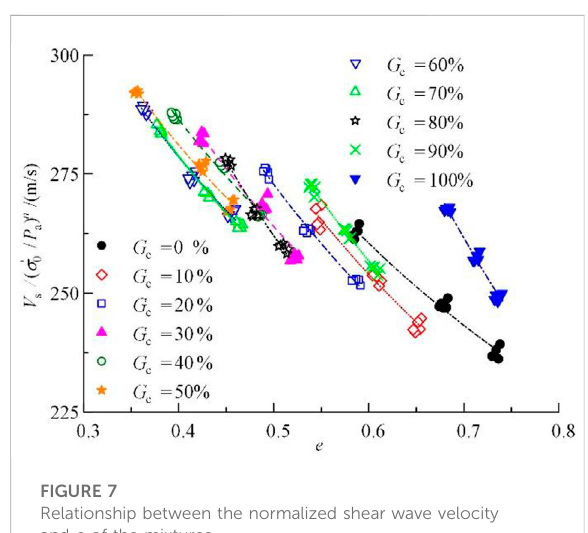
FIGURE 7 Relationship between the normalized shear wave velocity and e of the